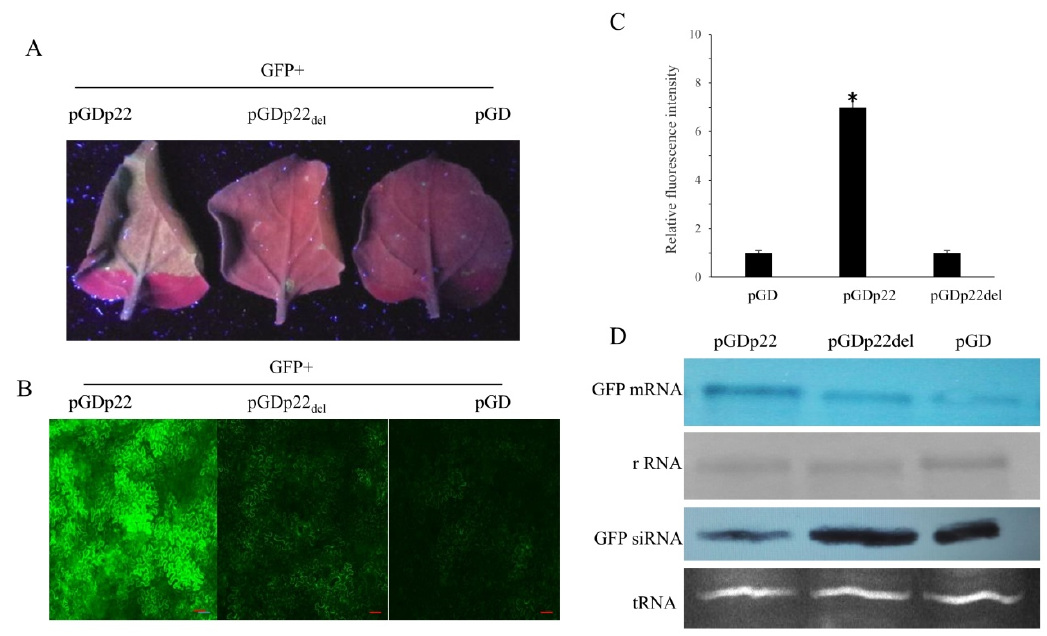
Figure 5. The F-box-like motif deletion abolished p22 silencing suppressor activity. ( A ) Ultraviolet light image taken 4 days post-infiltration (dpi). Nicotiana benthamiana leaves infiltrated with Agrobacterium harboring GFP with pGD empty vector, pGDp22, or pGDp22 del . ( B ) At 4 dpi, GFP fluorescence images of agro-infiltrated leaves were taken under a Nikon ECLIPSE Ti-S fluorescence microscope. The scale bar represents 20 µ m. ( C ) The GFP fluorescence intensity was measured using ImageJ software v1.40 (NIH). Thirty independent images for each group were measured, and values were analyzed using a t -test. The error bars correspond to standard errors. Three biological replicates were performed. ( D ) Northern blot analysis of GFP mRNA and siRNA extracted from agroinfiltrated zones at 4 dpi. Ethidium bromide staining of rRNA and tRNA was used as a loading control for mRNA and siRNA, respectively. GFP mRNAs and siRNAs were hybridized with a DIG-labeled GFP